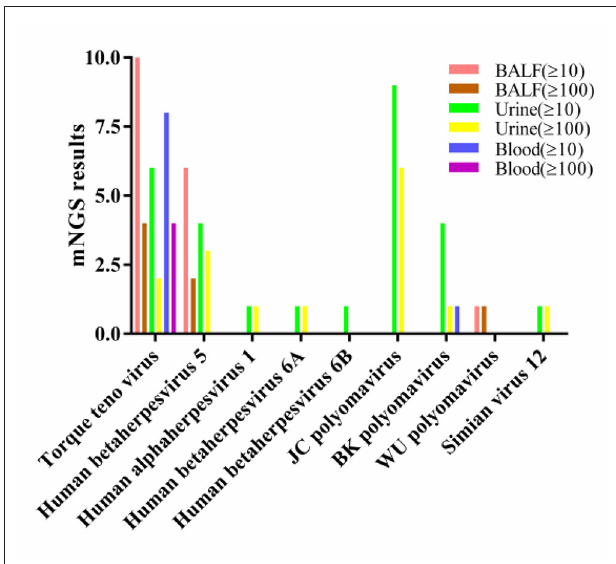
FIGURE 3 | Viral nucleic acid number of detected reads in three types of samples. BALF, bronchoalveolar lavage fluids.